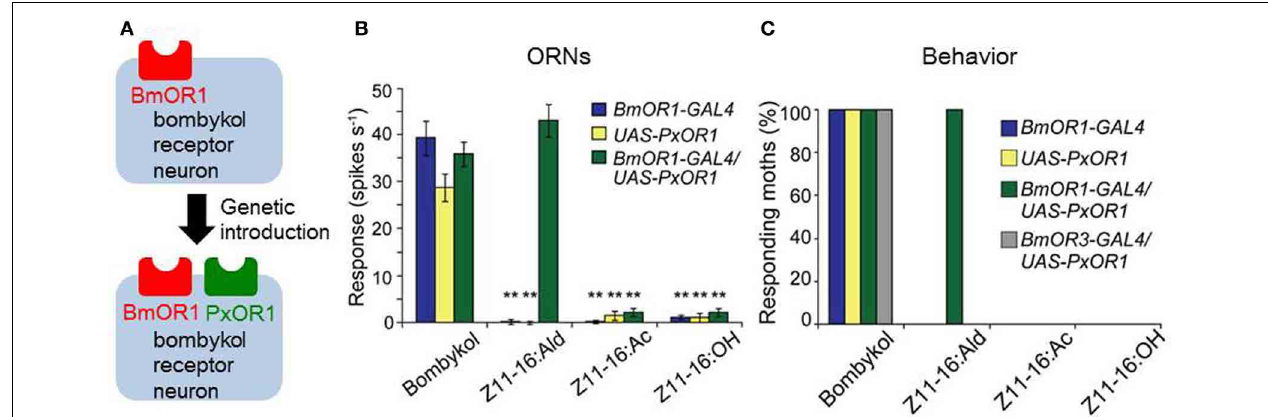
∗∗ p < 0 . 01 compared with responses of the corresponding line stimulated with bombykol; Scheffe’s F test. (C) Percentages of male moths that exhibit pheromone-source searching behavior. Artificial activation of bombykol-sensitive ORNs by Z11-16:Ald triggered the behavior, demonstrating that the activation of BmOR1-expressing bombykol-sensitive ORNs is sufficient for the initiation of pheromone-source searching behavior. Expression of PxOR1 in bombykal-sensitive ORNs by a BmOR3 promoter-GAL4 line (BmOR3-GAL4/UAS-PxOR1) did not confer behavioral responsiveness to Z11-16:Ald. (modified from Sakurai et al.,